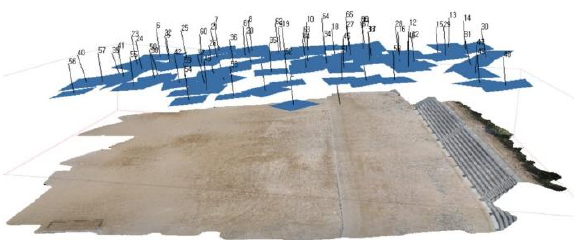
Figure 8. Location of the recored image and